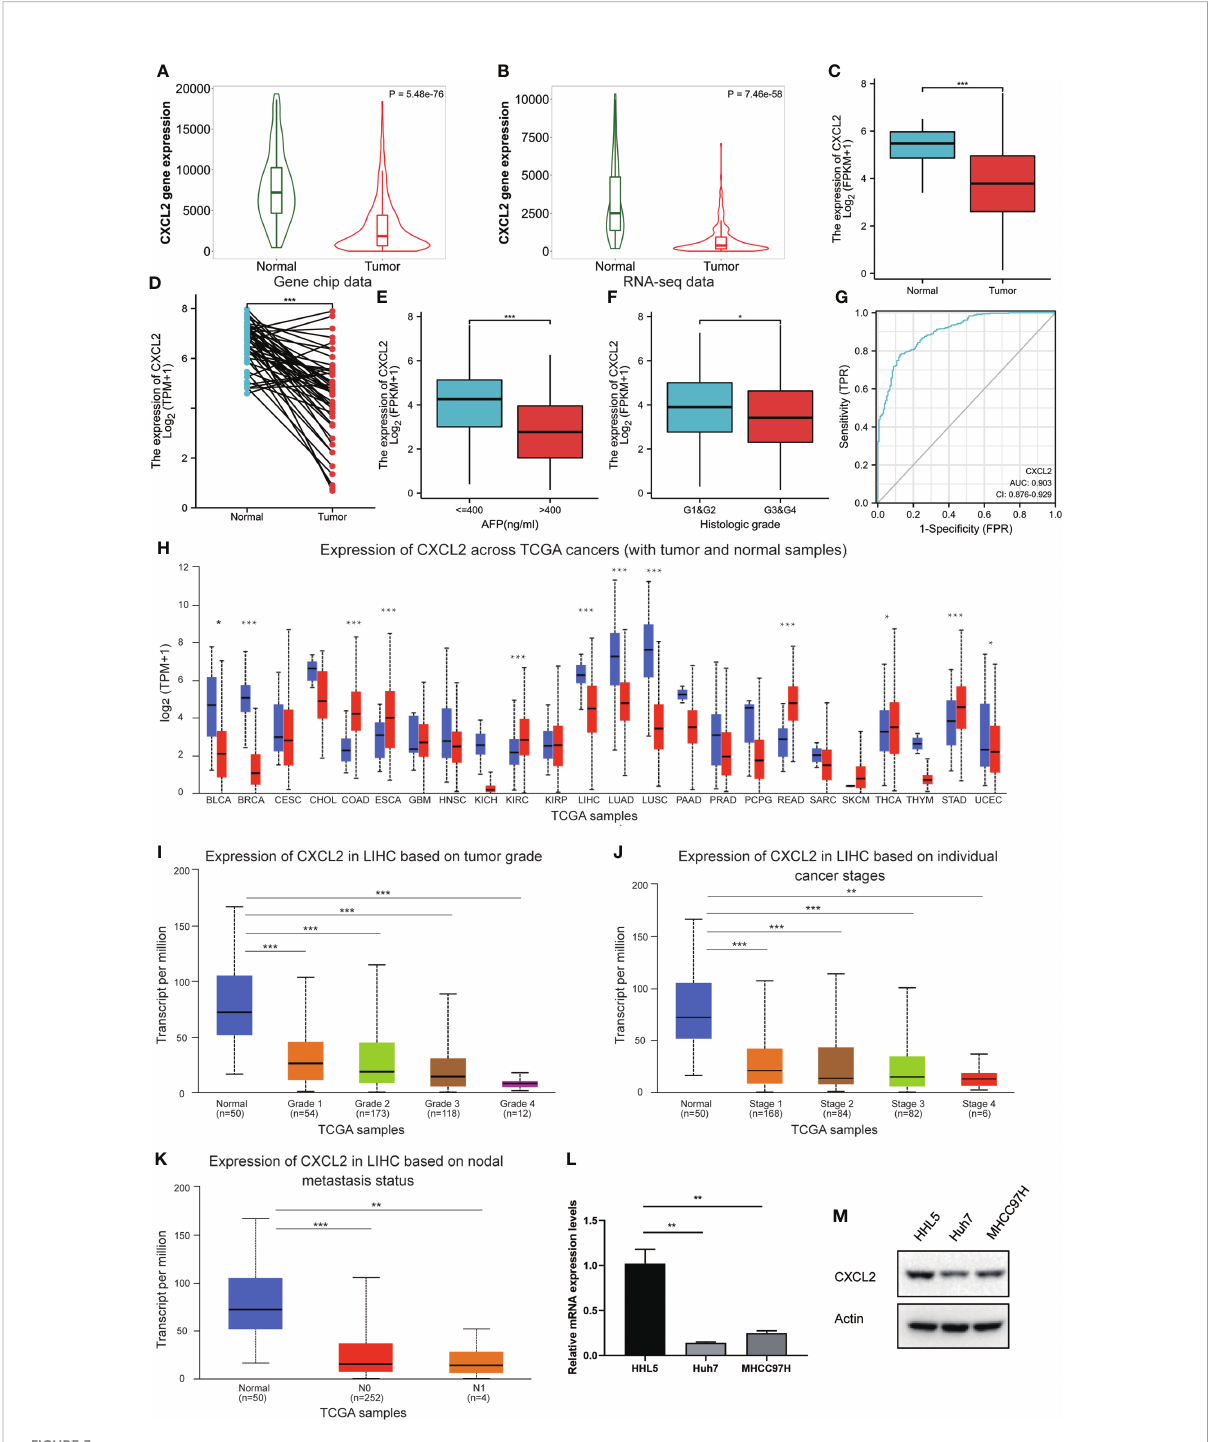
FIGURE 3 The expression level and clinicopathologic characteristics of CXCL2 in HCC. (A, B) Low expression of CXCL2 in HCC samples in gene chip data and RNA-seq data of TNMplot database. (C, D) The validation of low expression of CXCL2 in HCC samples in TCGA-LIHC cohort (C) or in comparison with matched adjacent para-tumor tissues (D) by Xiantao tool. (E, F) Correlation of CXCL2 expression with AFP (E) and histologic grade (F) . (G) Receiver operation characteristic (ROC) curve to evaluate the diagnostic value of CXCL2 in HCC. (H) Expression pattern of CXCL2 across diverse TCGA cancer types by UALCAN database. (I-K) Correlation of CXCL2 expression with tumor grade (I) , stage (J) , and nodal metastasis (K) . (L, M) Low expression of CXCL2 in two HCC cell lines, Huh7 and MHCC97H, was further con fi rmed by real-time PCR (L) and western blotting (M) , compared with the normal hepatocyte cell line HHL-5. * represents P < 0.05, ** represents P < 0.01, *** represents P <